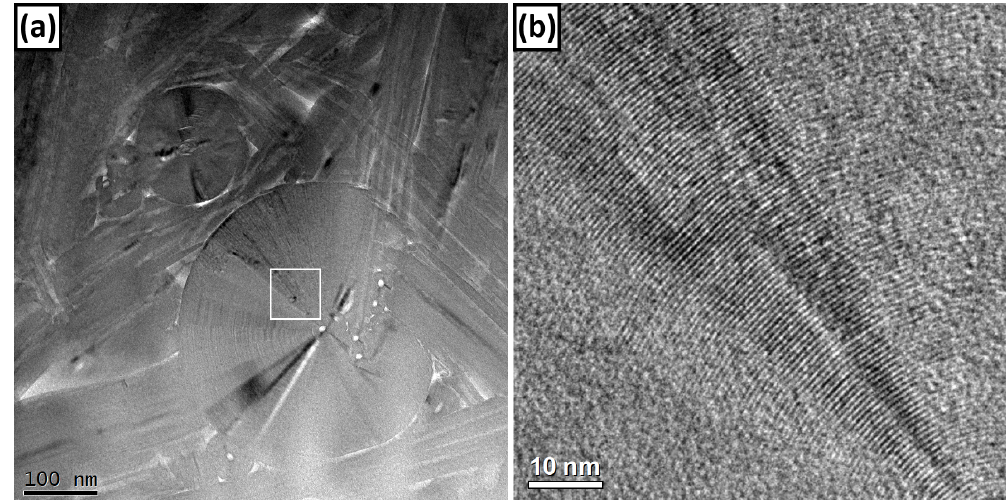
Figure 6. TEM results. (a) Polygonal serpentine within lizardite and (b) high-resolution image of the polygonal sectors. The abrupt deflection of the flat lizardite-like lattice planes is